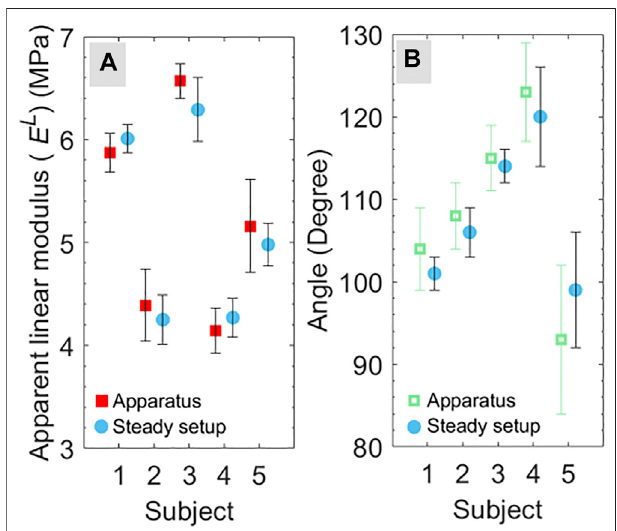
FIGURE 7 | Comparison of (A) maximum apparent linear modulus and (B) direction corresponding to maximum linear modulus for the test conducted using the apparatus and steady setup for fi ve subjects (from S1 to